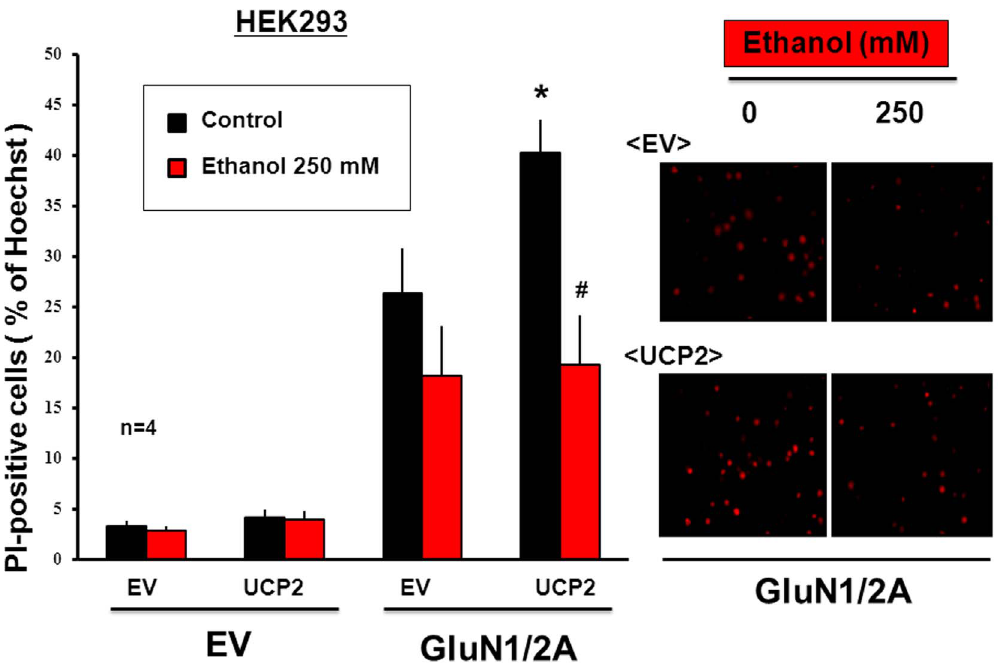
Figure 10. Effects of ethanol on cellular survival in HEK293 cells with GluN1/GluN2A subunits. HEK293 cells were transfected with expression vectors of GluN1 and GluN2A subunits along with Flag-UCP2, followed by further culture for an additional 24 h in either the presence or absence of 250 mM ethanol and subsequent DNA staining with Hoechst33343 and PI for determination of cellular viability. Values are percentages of PI-positive cells over Hoechst33343-positive cells in 4 independent determinations. *P , 0.05, significantly different from each control value obtained in cells with EV alone. # P , 0.05, significantly different from the value obtained in cells not exposed to ethanol. Statistical significance was determined according to the Students’ t -testanalysis.